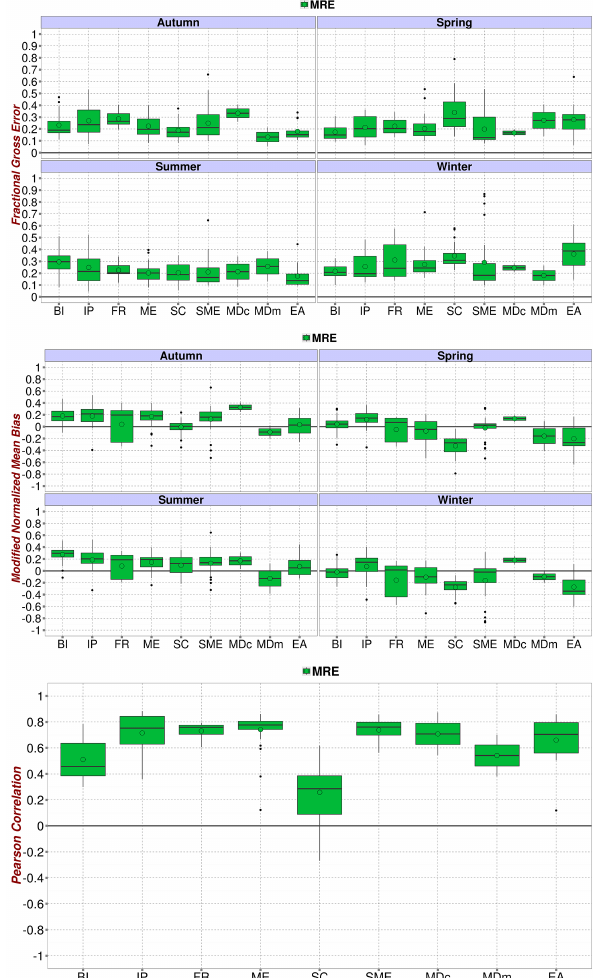
Figure 2. Average 2003–2012 seasonal FGE (top), MNMB (mid- dle) and annual R (bottom) of near-surface ozone for the different European subregions of the MACC reanalysis. The color dots cor- respond to means. The bottom and top of the box are the first and third quartiles (Q1 or 25th percentile and Q3 or 75th percentile) and the vertical horizontal line in the box is the median (Q2 or 50th per- centile). The colored points on each box indicate the mean